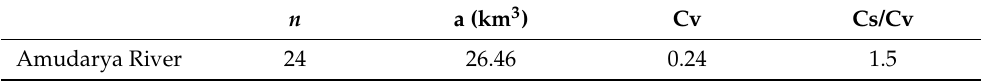
Table 3. Water supply under different guaranteed rates.